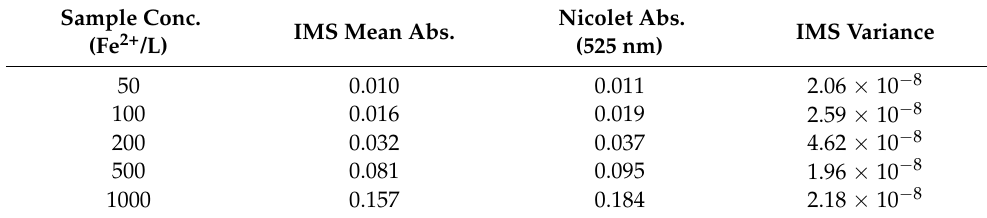
Table 4. Measurement of absorbance in first series of iron standard samples. Sample Conc. Sample